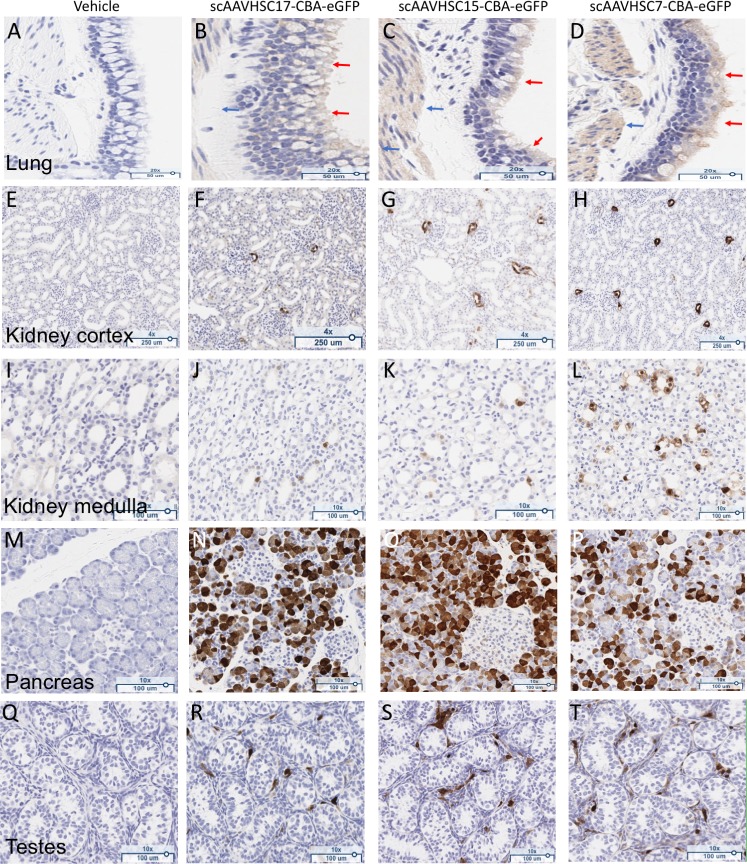
eGFP staining in peripheral tissues of Cynomolgus macaques dosed with scAAVHSC-CBA-eGFP.(A, E, I, M, Q) The animal received an IV dose of vehicle alone. (B, F, J, N, R) The animal received an IV dose of scAAVHSC17-CBA-eGFP. (C, G, K, O, S) The animal received an IV dose of scAAVHSC15-CBA-eGFP. (D, H, L, P, T) The animal received an IV dose of scAAVHSC7-CBA-eGFP. Tissues were processed for eGFP staining as described under Materials and methods. Representative tissues shown are: lung, large airway epithelium (A-D), kidney cortex (E-H); kidney medulla (I-L), pancreas (M-P), and testes (Q-T). Brown staining represents eGFP staining.